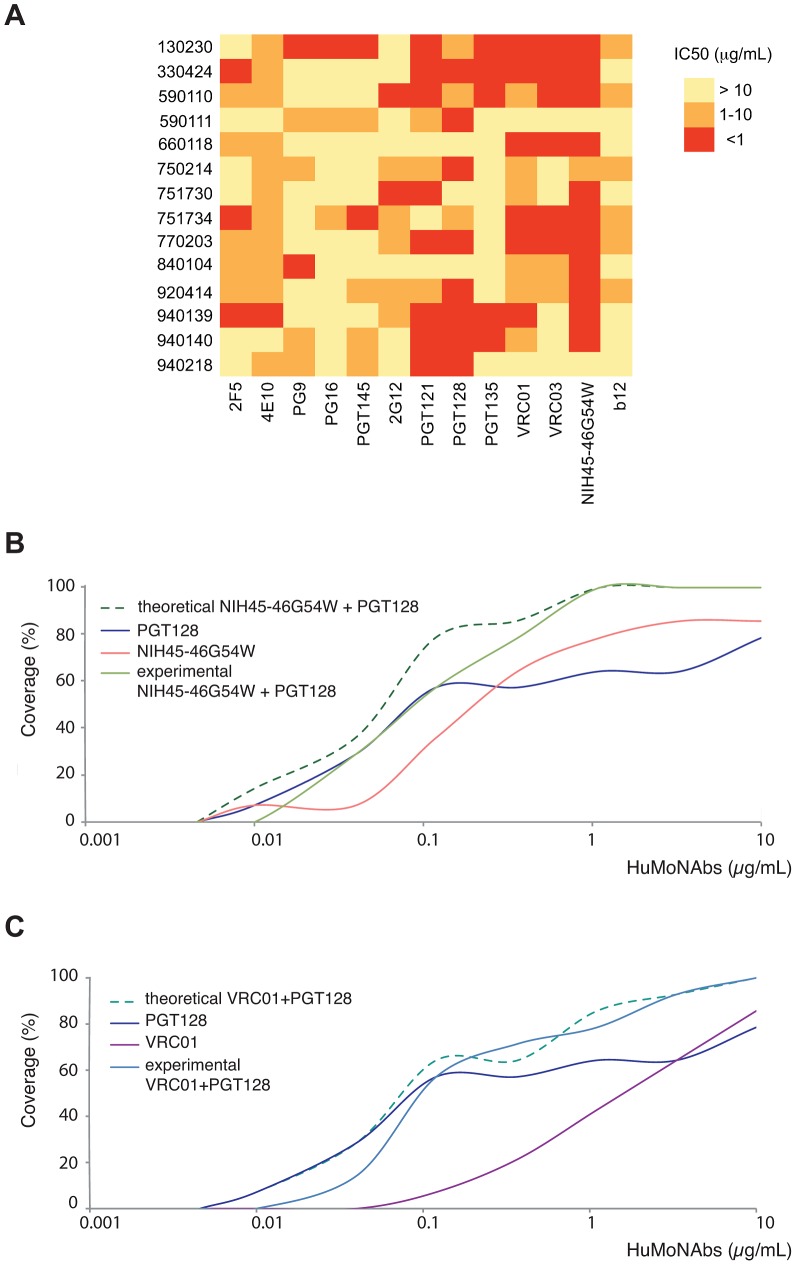
Neutralization coverage of HIV-1 variants from contemporary patients by HuMoNAbs combinations.[A] A heatmap of the neutralizing activities (IC50) of the HuMoNAbs against HIV-1 variants from contemporary patients is shown, with increasing darker colors indicating increasing neutralization sensitivity. [B and C] The neutralization coverage of viruses from contemporary patients was tested against various concentrations of a 1∶1 combination of NIH45-45G54W and PGT128 [B] and a 1∶1 combination of VRC01 and PGT128 [C]. Solid lines show the coverage of each HuMoNAb used alone or in combinations. Dashed lines show the theoretical coverage that would be obtained if the neutralizing activities of combined antibodies were fully additive.